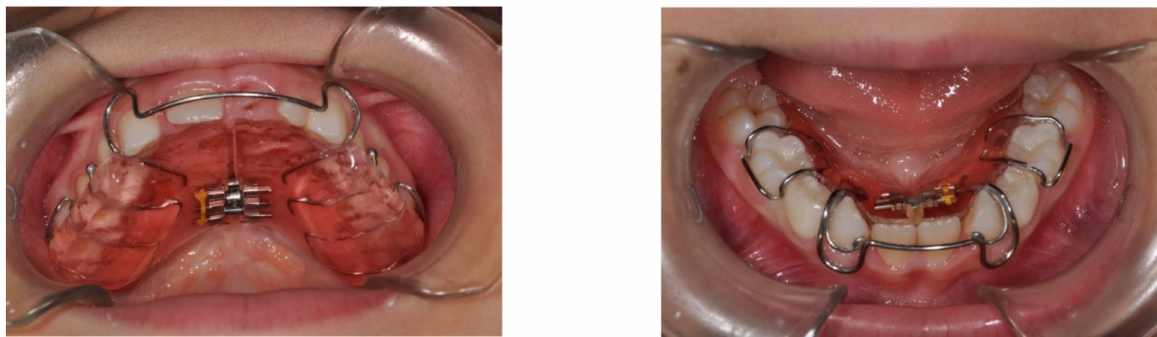
Figure 2. Examples of orthodontic plates with transversal